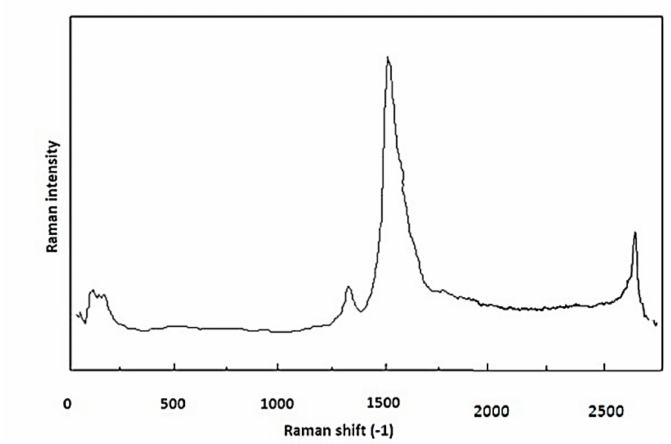
Figure 10. Raman spectra of the CNTs synthesizing in optimum conditions (catalyst concentration = 3.79 wt %, hydrogen flow = 185 cm 3 /min, and temperature = 975 ◦ C, ( I G /I D ) =